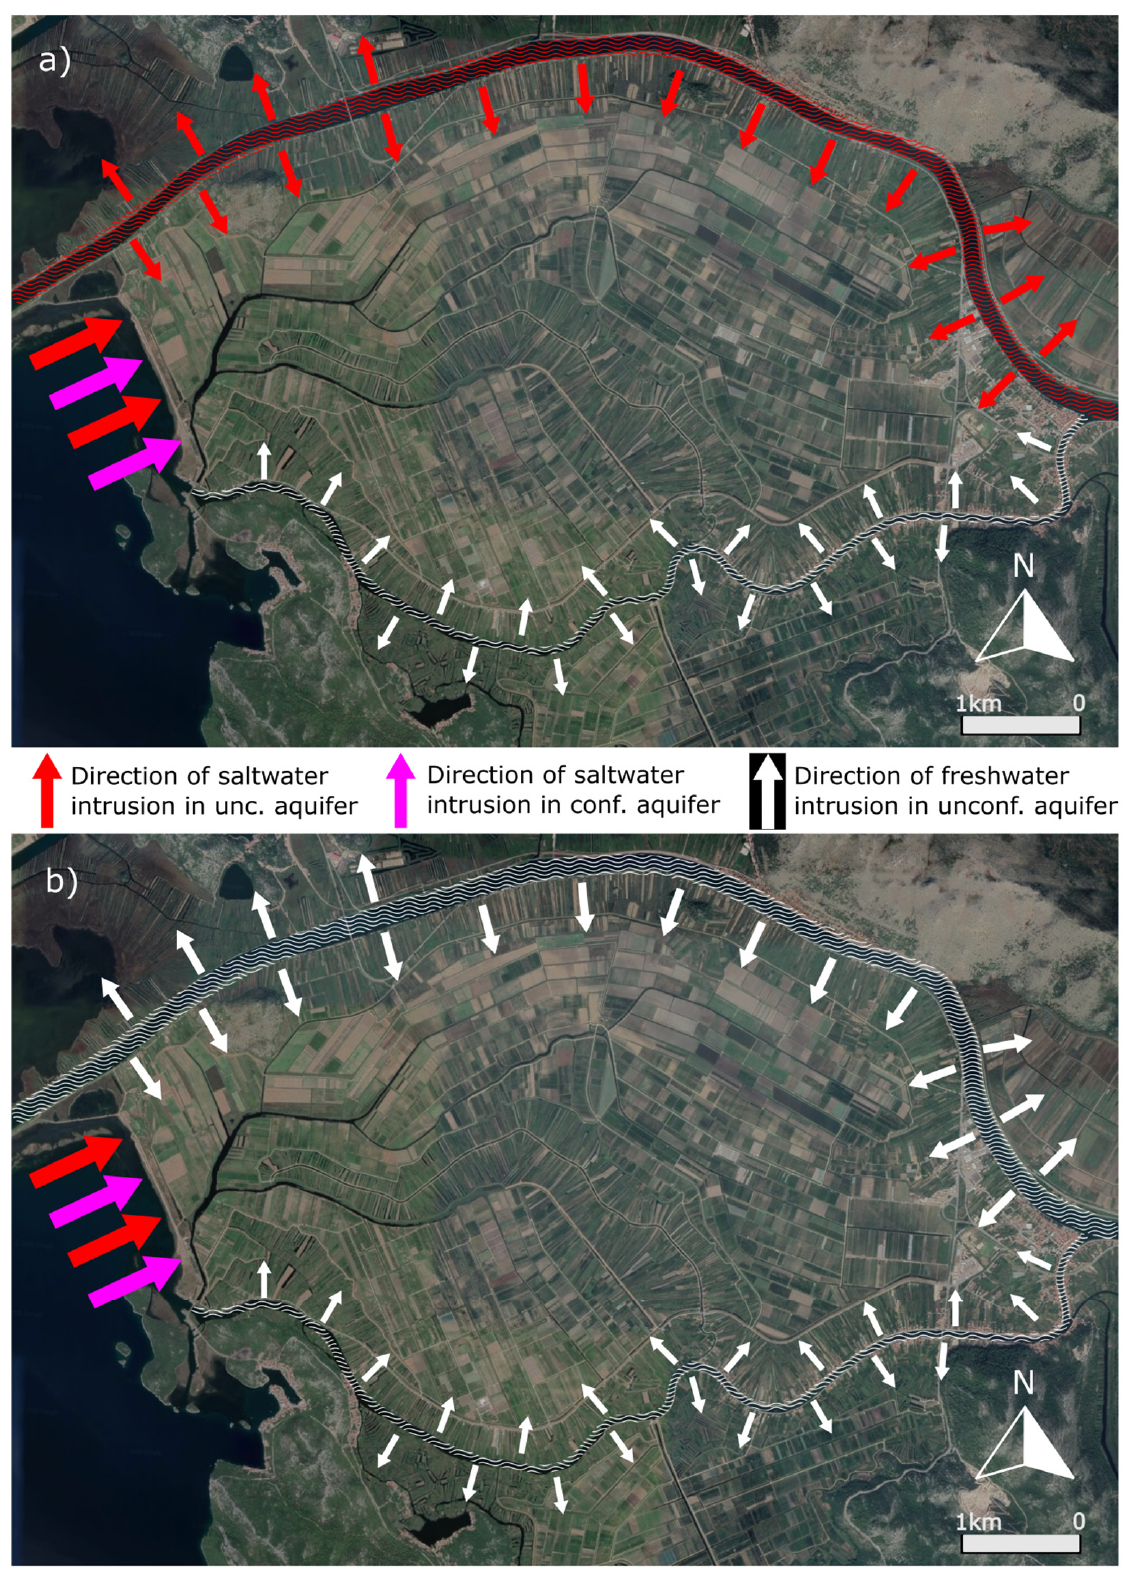
Figure 14. Conceptual definition of the Neretva Valley area sea water intrusion (SWI) pathways: ( a ) summer (dry) period; ( b ) winter (rain)